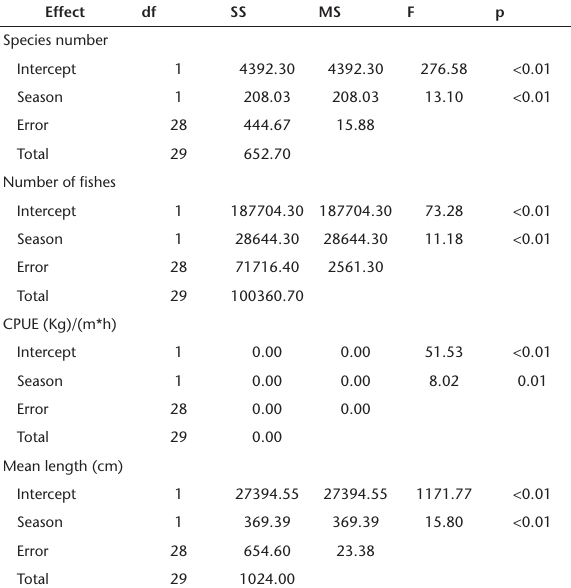
Table 1. Analysis of variance tables to compare seasonal effects on species number, number of fishes, CPUE and mean length for fishes caught at the coast of Alagoas.